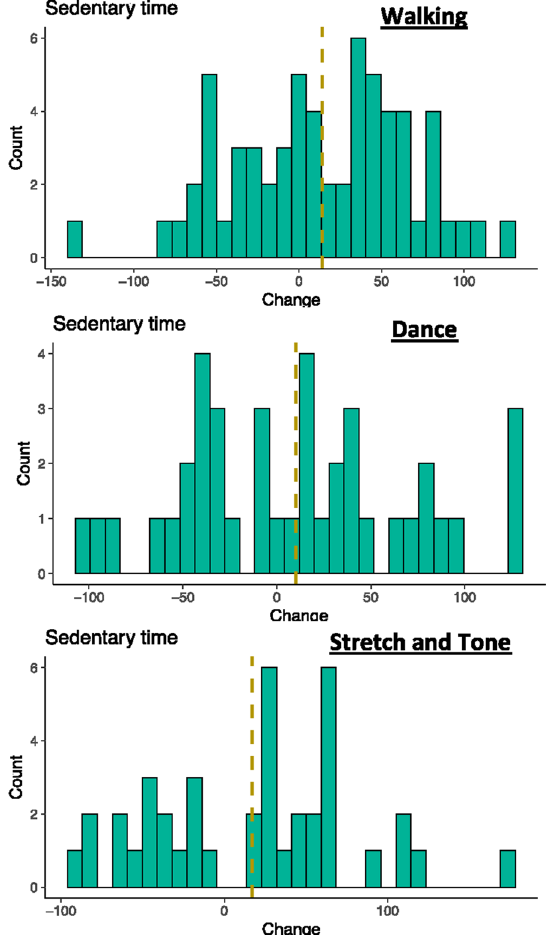
Figure 2. Histograms of participant changes in sedentary time over the 6-month interventions. A numerically similar proportion of individuals increased as decreased their time spent sedentary. Gold vertical line represents the mean change, “0” on the x-axis represents no change.